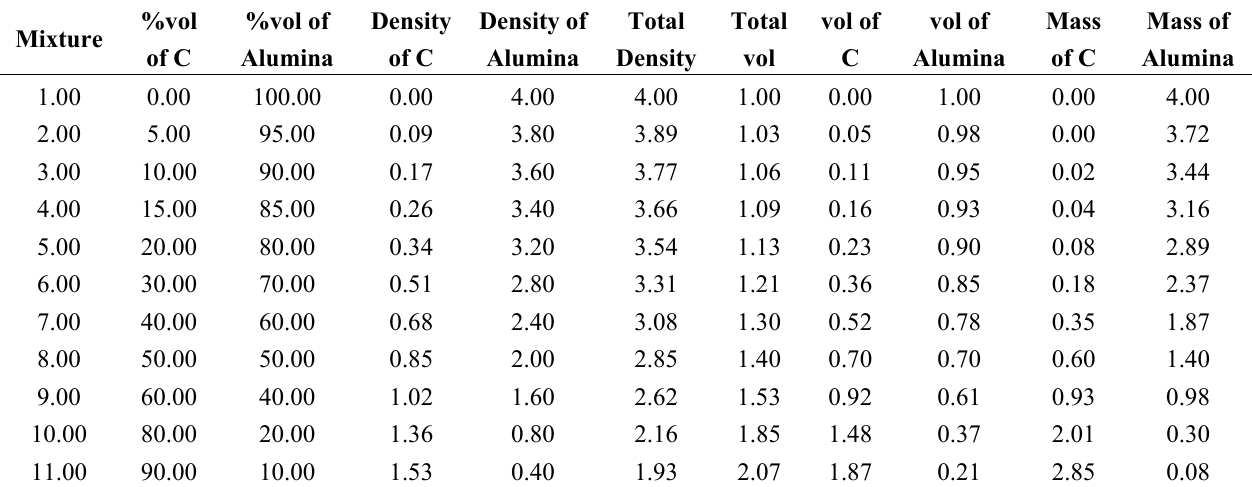
Table 1. Mixing ratios of carbon and granulated